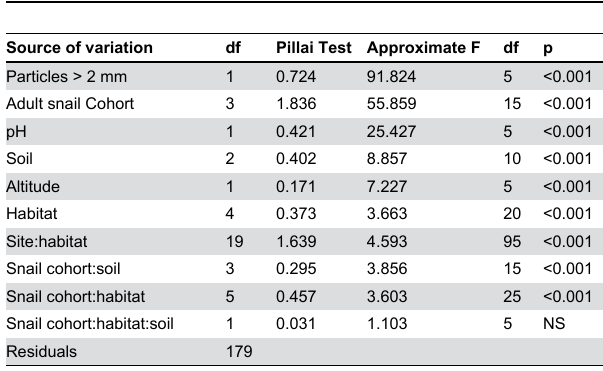
Table 1. Summary of MANOVA made on shell parameters to compare clusters after RDA.